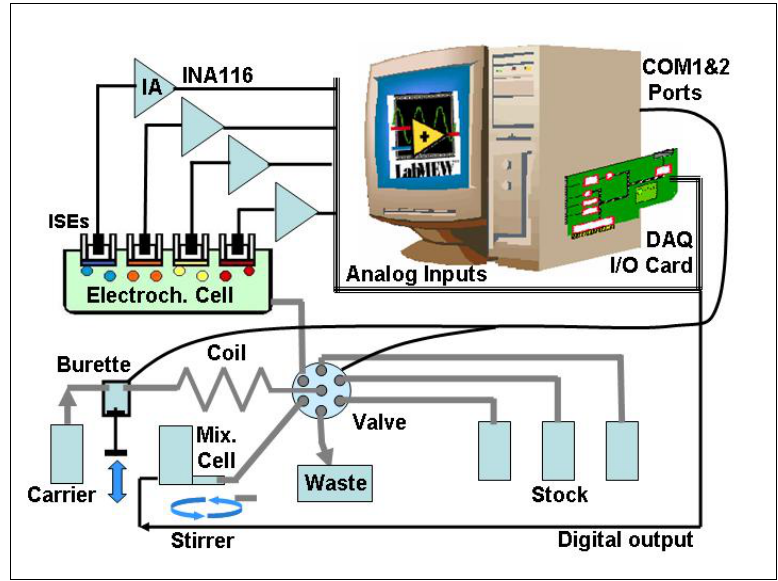
Figure 2. Manifold and hardware used for the developed automated